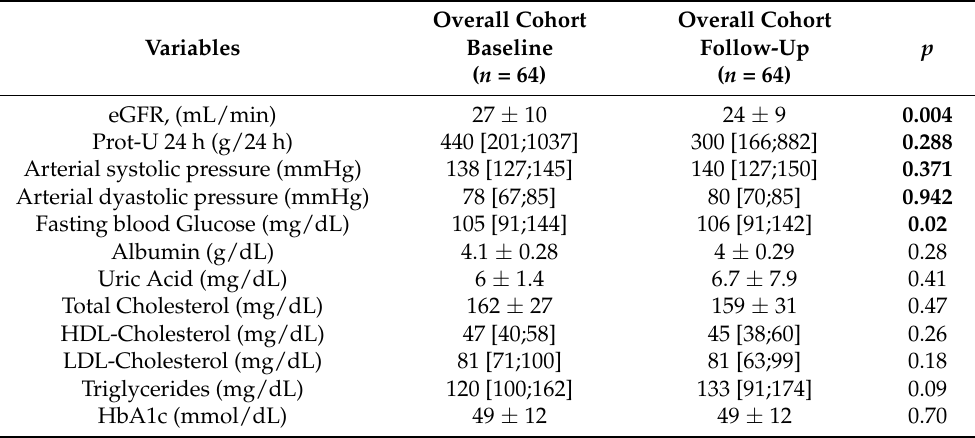
Table 2. Metabolic and renal function parameters at baseline and follow-up.